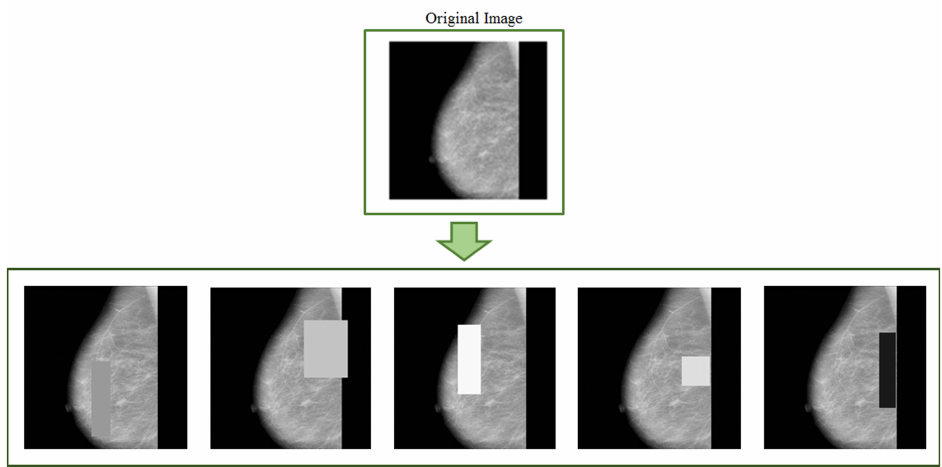
Figure 6. Mammograms after applying random